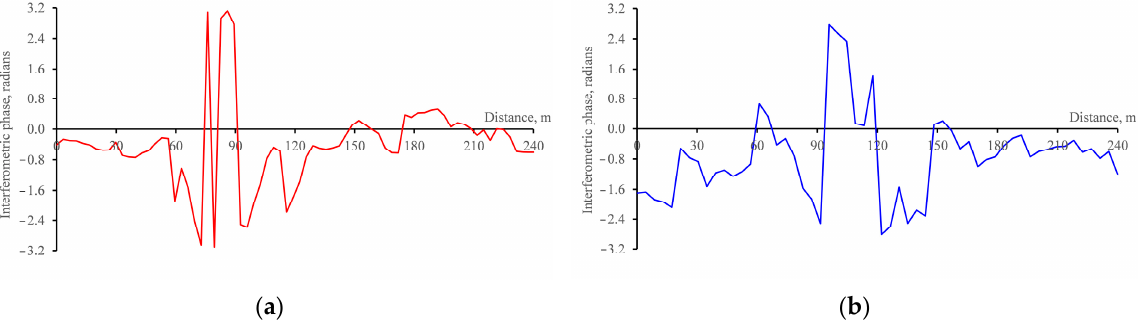
Figure 7. Interferometric phase profile for the pair of images from 10 January 2019–9 January 2020: ( a )—along the LOS; ( b )—across the LOS.